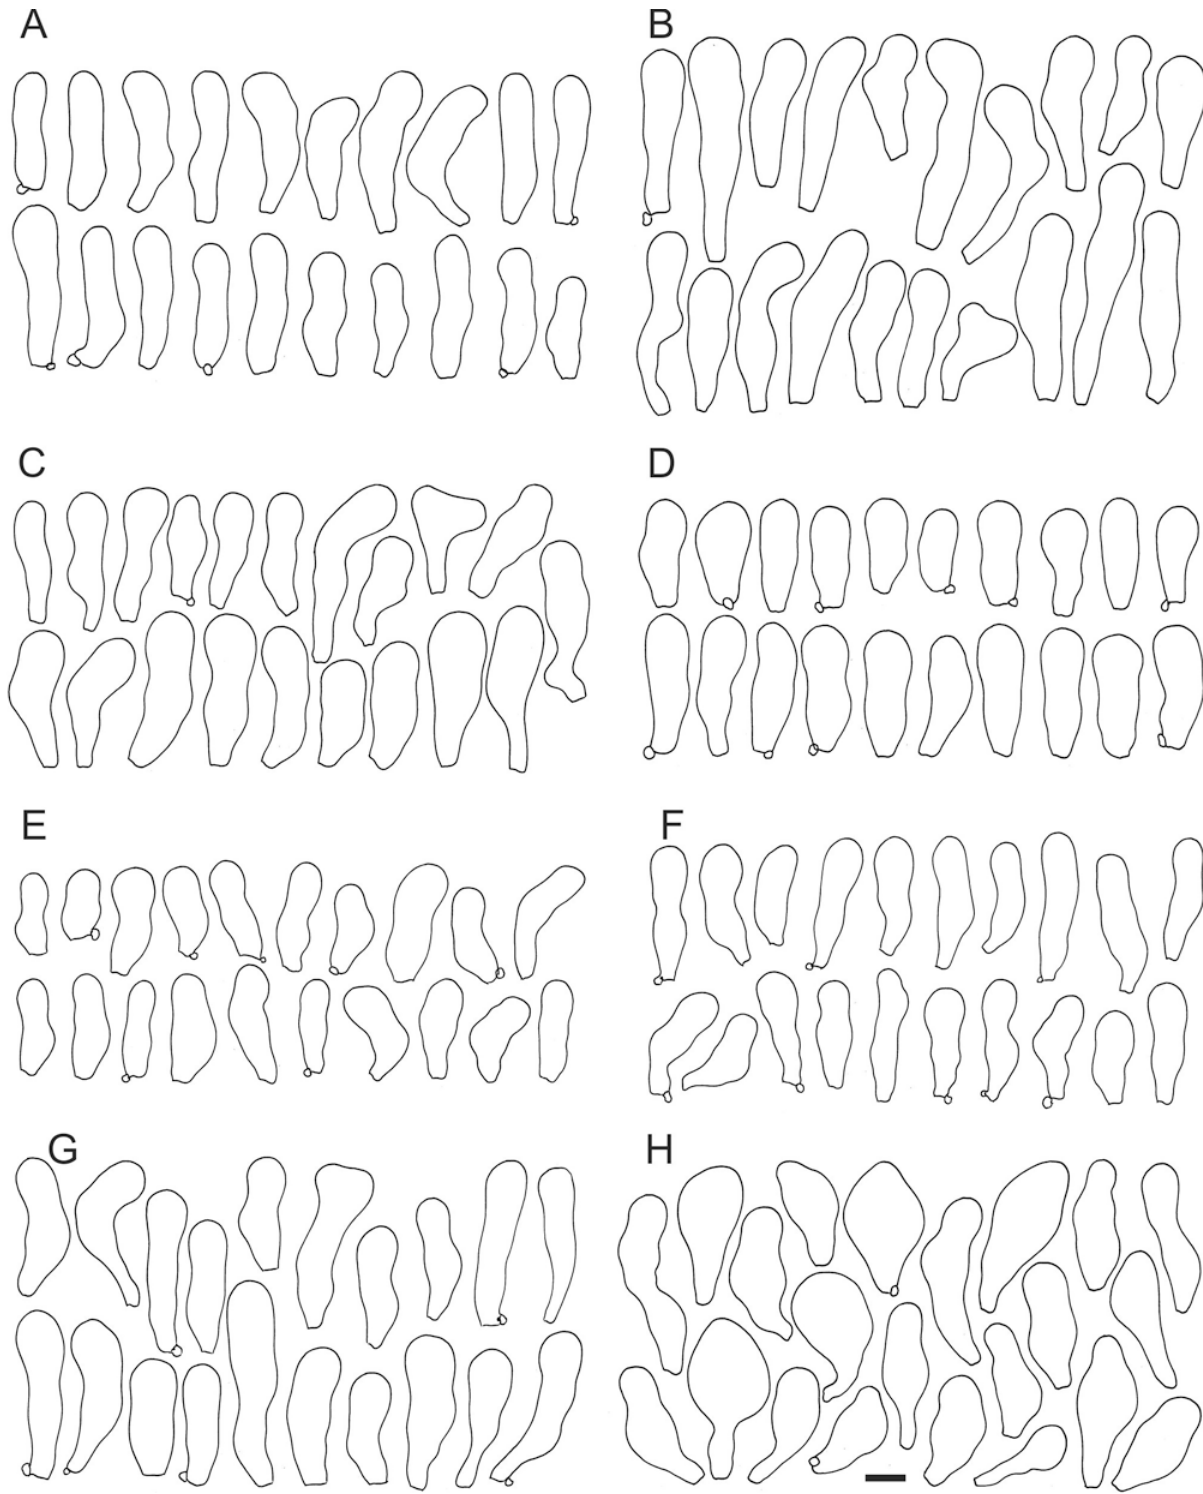
Figure 6. Cheilocystidia variability of Crepidotus malachius . ( A ) SLO 1845, ( B ) SLO 479, ( C ) SLO 1497, ( D ) SLO 2530, ( E ) SLO 2540, ( F ) SLO 2541, ( G ) SLO 2552, ( H ) SLO 2548. Scale bar = 10 μm.